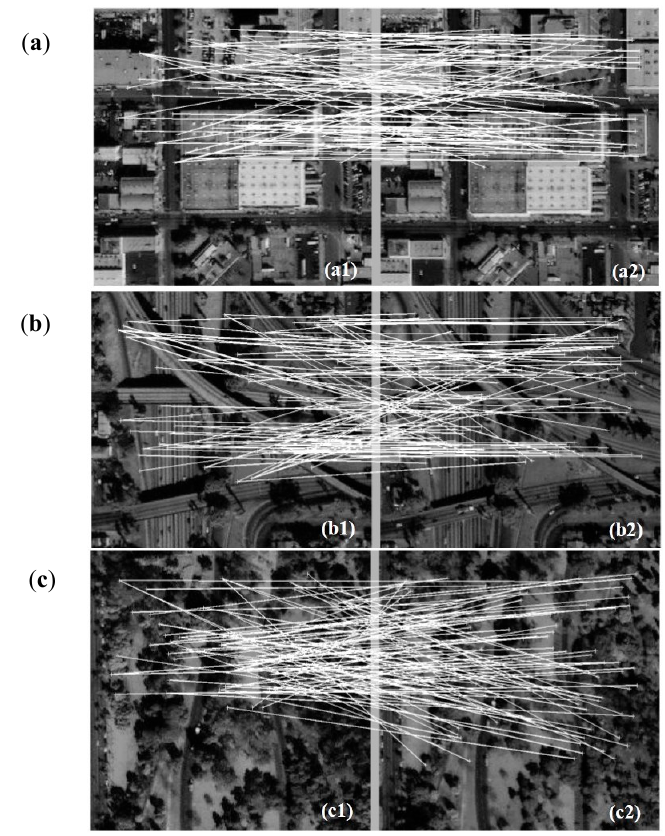
Figure 10. Detection and matching in image pairs with building ( a ), road ( b ), and wood ( c ).